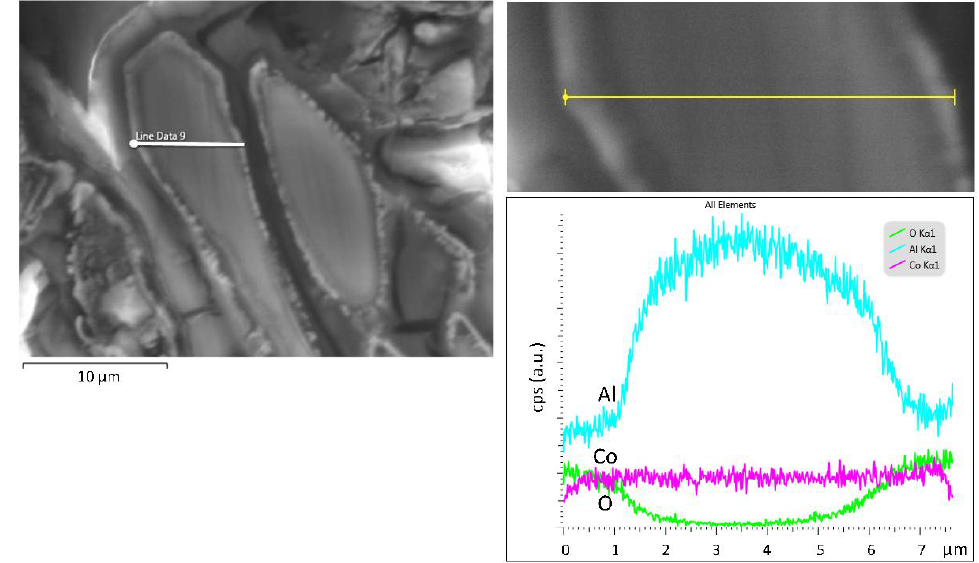
Figure 9. Cross-section (SE mode) of Al‐15 wt.% Co after cyclic polarization (3.5 wt.% NaCl, 25 °C) and EDX line scan across a blade of Al 9 Co 2 .